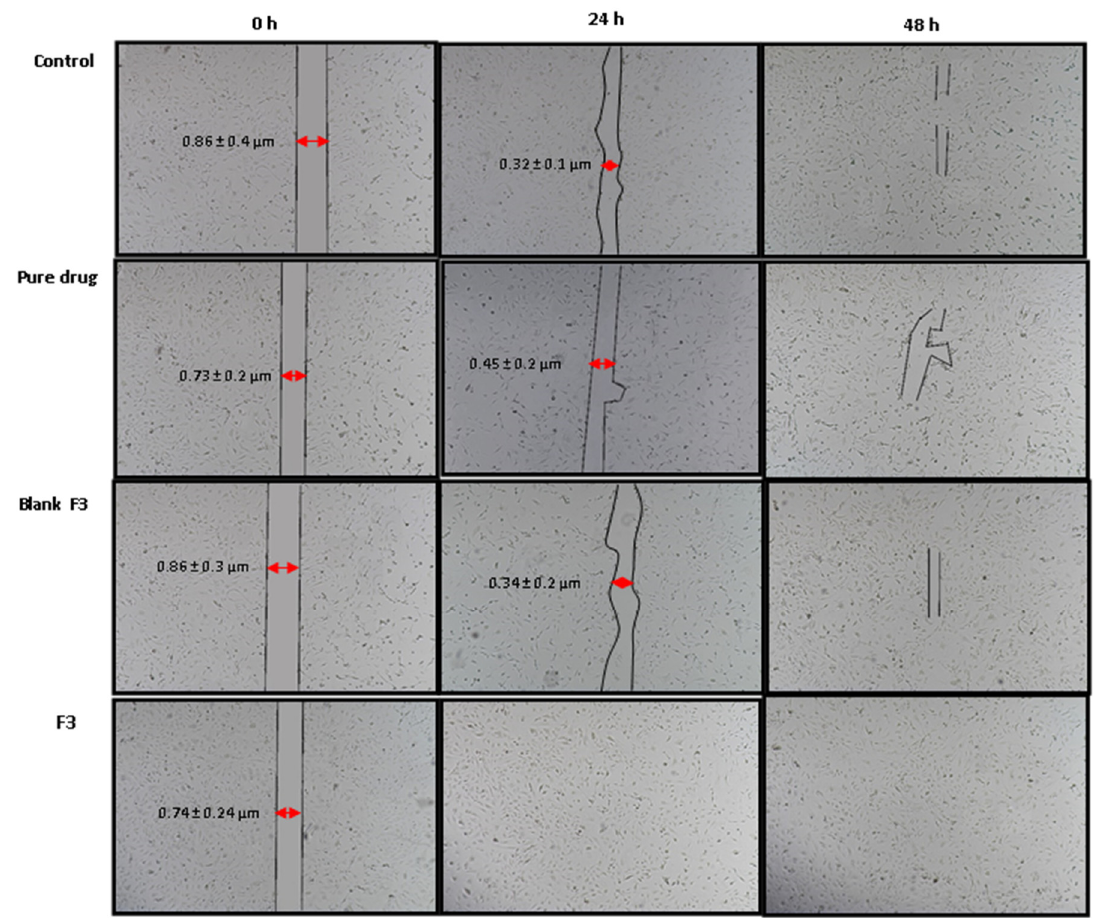
Figure 7. Cell migration upon the curcumin-loaded SEDDS treatment.